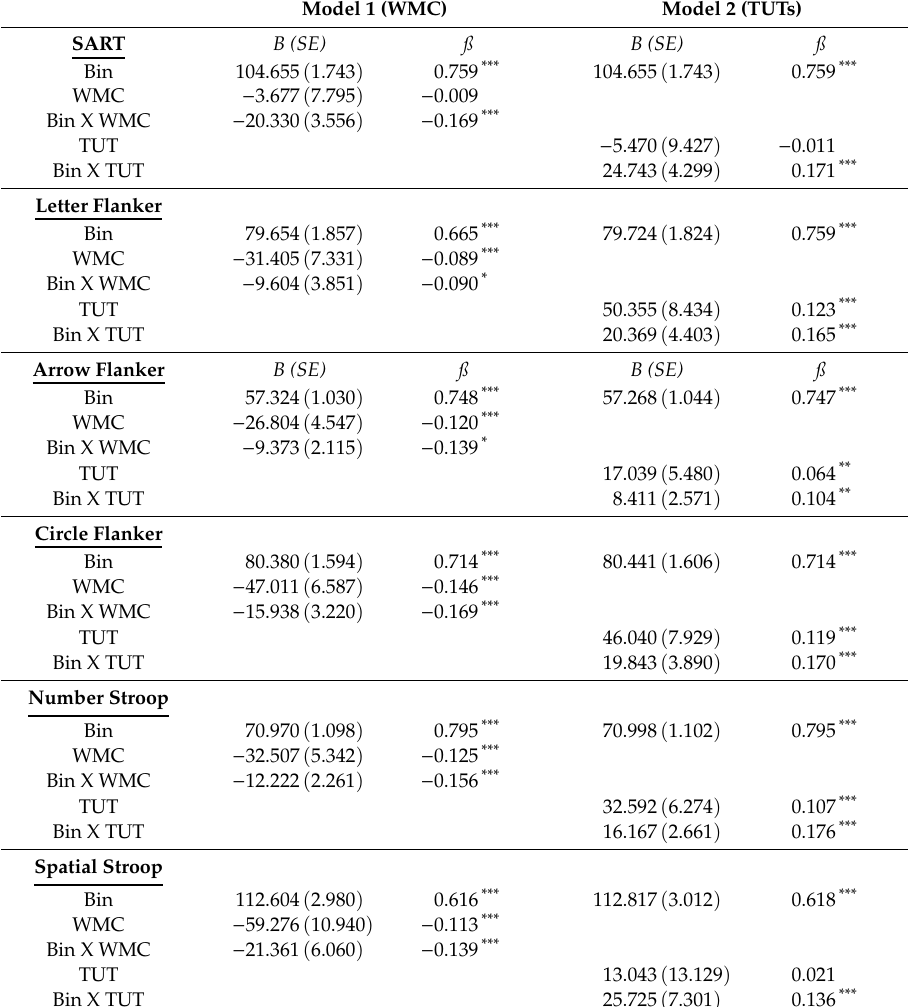
Table 2. Hierarchical regressions examining the interaction between cognitive predictors and bin each task in predicting